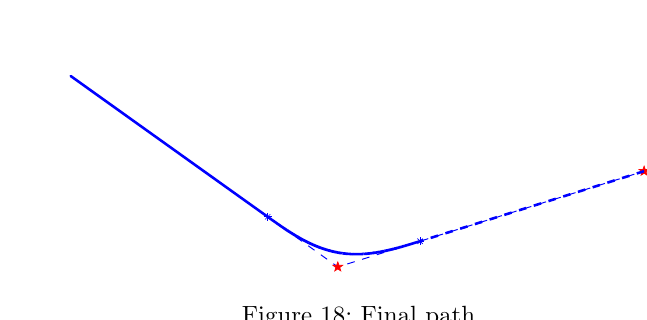
Figure 17: Wheel over and pull out points